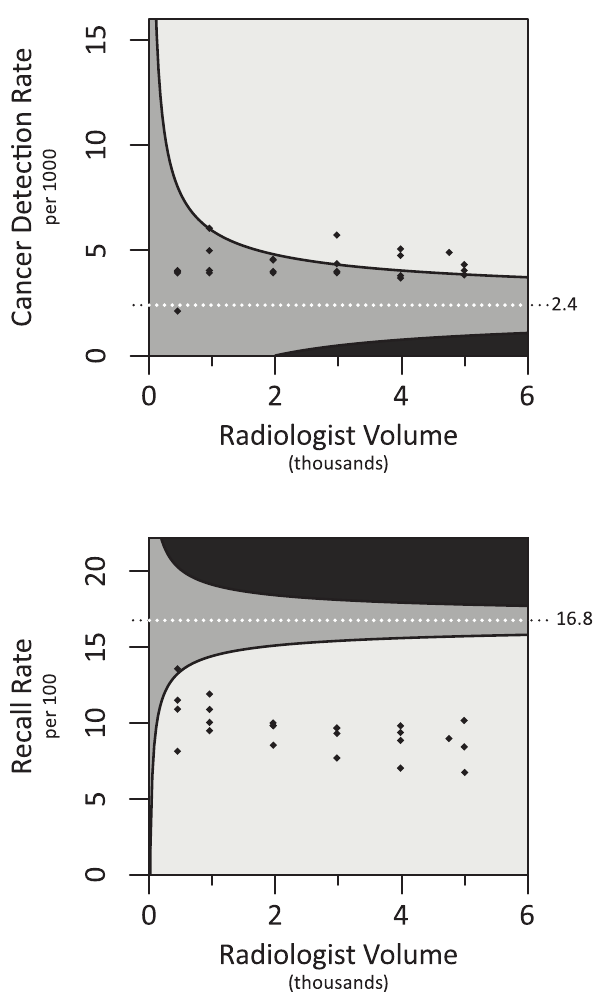
Figure 2. Individual physician performance assessment based on volume. Plots of (A) CDR and (B) RR for the 4 included radiologists at 6 volumes from 500 examinations (then at 1000 and subsequently 1000 exam increments) to the maximum volume read over the 3 years or 5000 total (whichever was least).